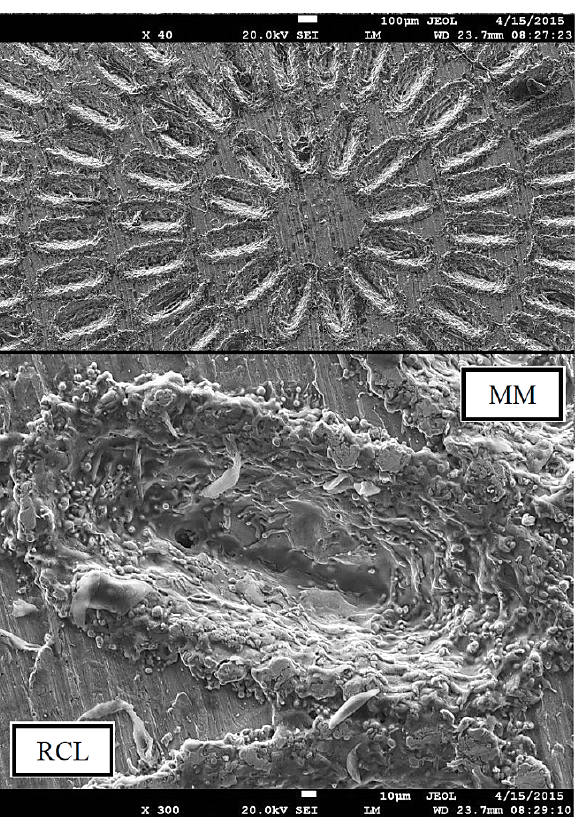
Figure 7: Planar surface if sample I covered by texture III.